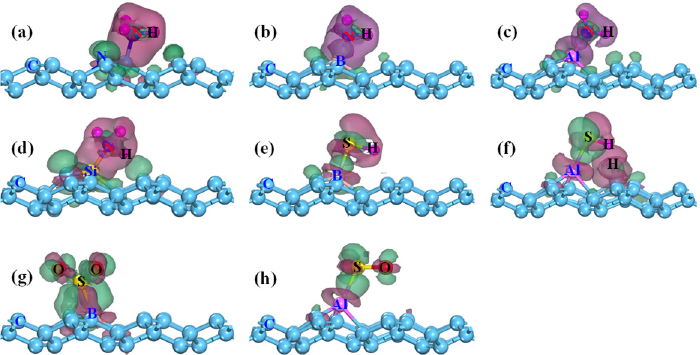
Figure 7. Difference charge density of different adsorption systems ( a ) NH 3 @N-PG, ( b ) NH 3 @B-PG, ( c ) NH 3 @Al-PG, ( d ) NH 3 @Si-PG, ( e ) H 2 S@B-PG, ( f ) H 2 S@Al-PG, ( g ) SO 2 @B-PG, and ( h ) SO 2 @Al-PG. The green (red) region is electron accumulation (depletion), and the isosurface is ±0.02 e/Å − 3 .